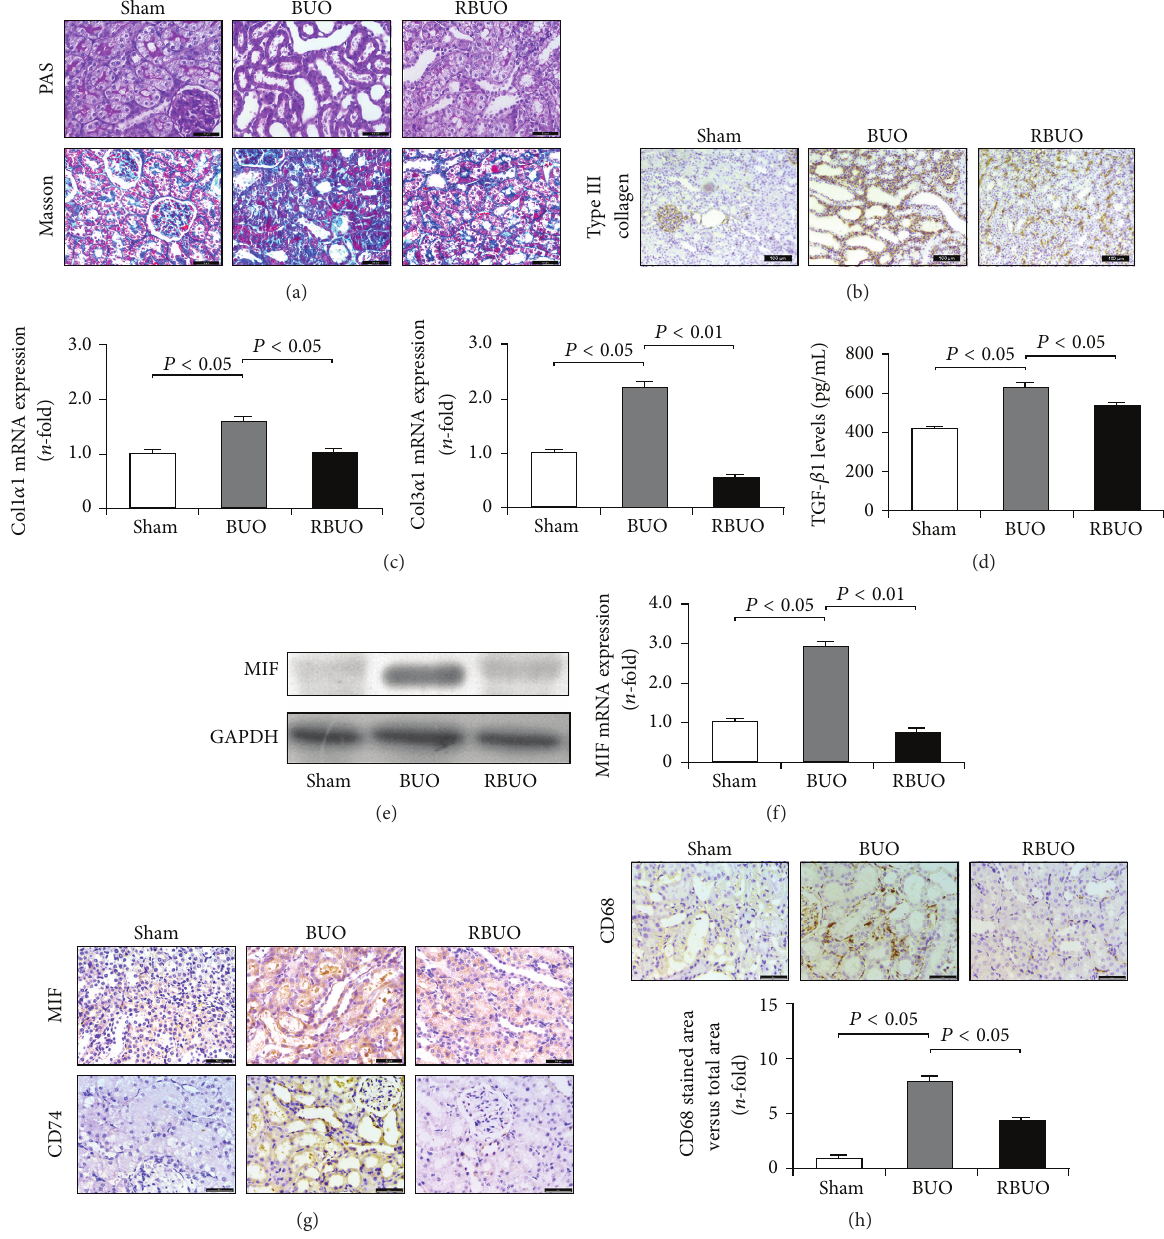
Figure 2: Recanalization reduced matrix deposition and MIF expression in obstructed kidneys. (a) PAS and Masson staining revealed that recanalization operation reduced obstruction-induced kidney injury, matrix deposition, and inflammatory cells infiltration in BUO rats. Bar: 50 𝜇 m. (b) Immunohistochemical staining showed that recanalization downregulated obstruction-induced protein expression of type III collagen. Bar: 100 𝜇 m. (c) Gene expression levels of Col1 𝛼 1 and Col3 𝛼 1 in BUO kidneys were significantly decreased after recanalization. (d) ELISA assay indicated reduced TGF- 𝛽 1 levels in recanalization kidneys compared with the BUO group. (e) Western blot analysis showed decreased MIF expression in recanalization kidneys. (f) qRT-PCR analysis showed reduced MIF expression in recanalization kidneys compared with the BUO group. (g) Immunohistochemical staining identified downregulated expression of MIF and CD74 in kidneys of recanalization rats. Bar: 50 𝜇 m. (h) Recanalization inhibited the infiltration of CD68-positive macrophages in BUO kidneys. Bar: 50 𝜇